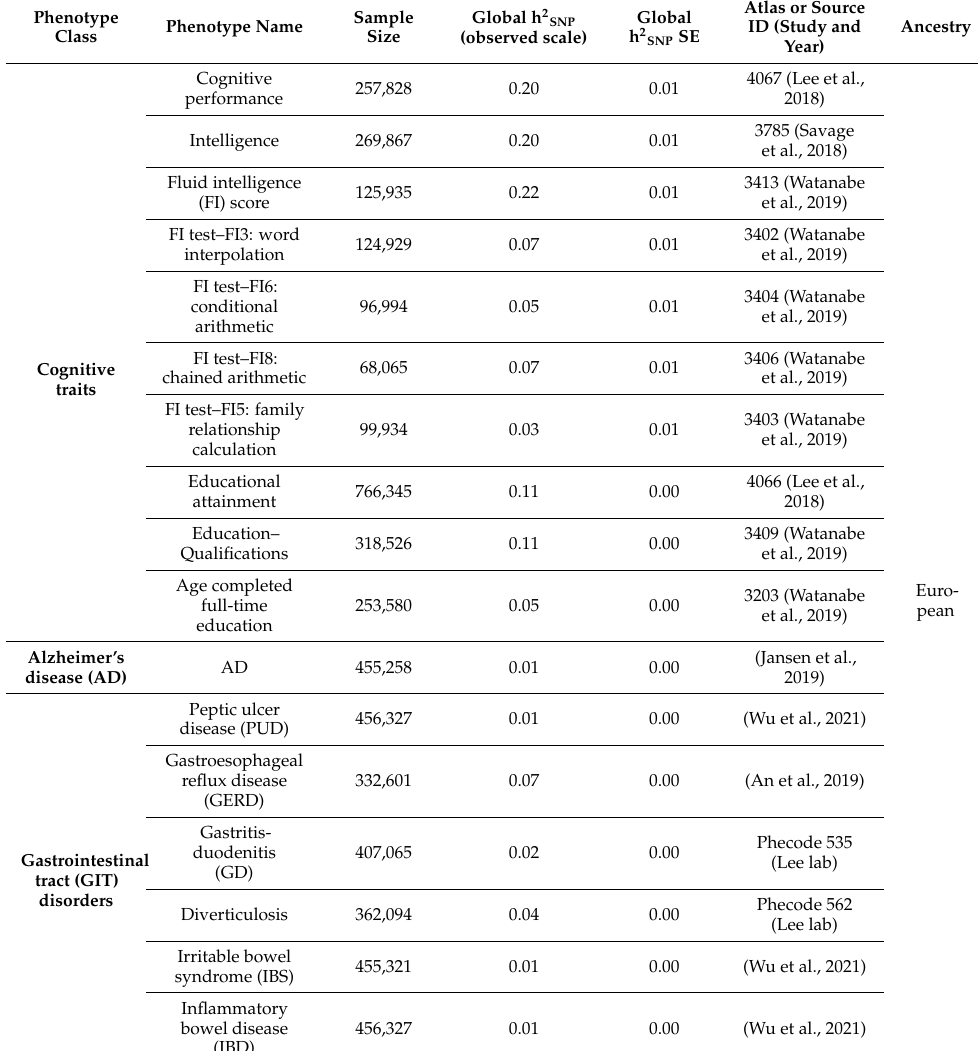
Table 1. Summary of the GWAS data analysed with heritability